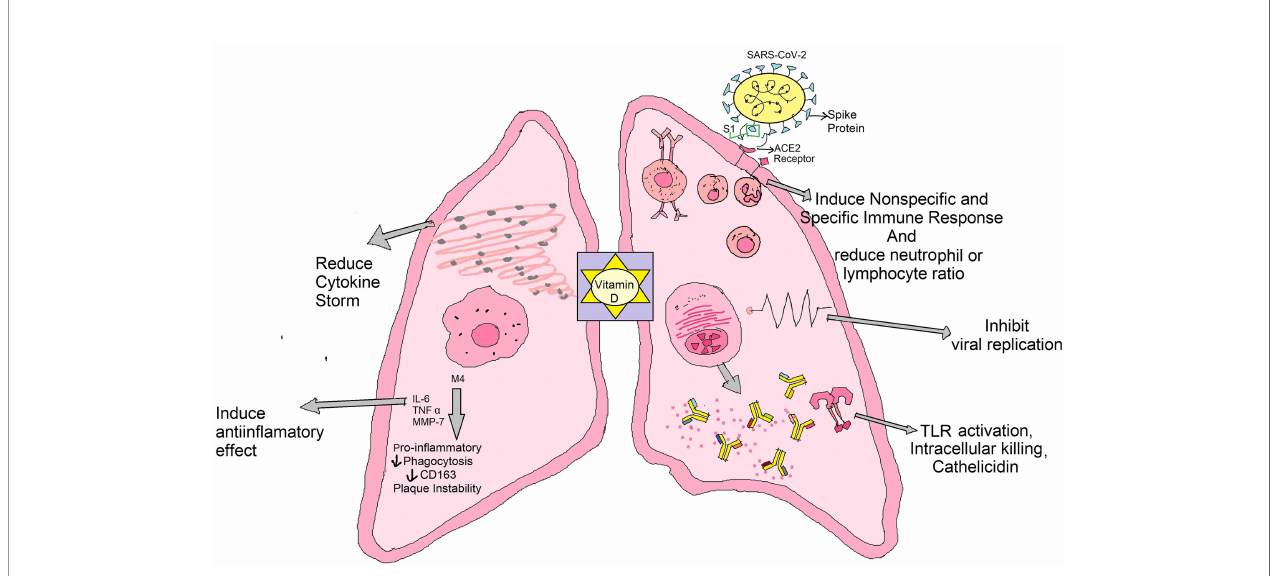
FIGURE 3 | Role of vitamin D against COVID-19: It has an impact on SARS-CoV-2 infection outcomes through a variety of mechanisms, such as inducing anti- in fl ammatory effects and/or lowering neutrophil/lymphocyte ratio, provoking innate and acquired anti-viral responses, interacting with cellular factor ACE2, conversing with viral aspects, and/or disrupting virus life